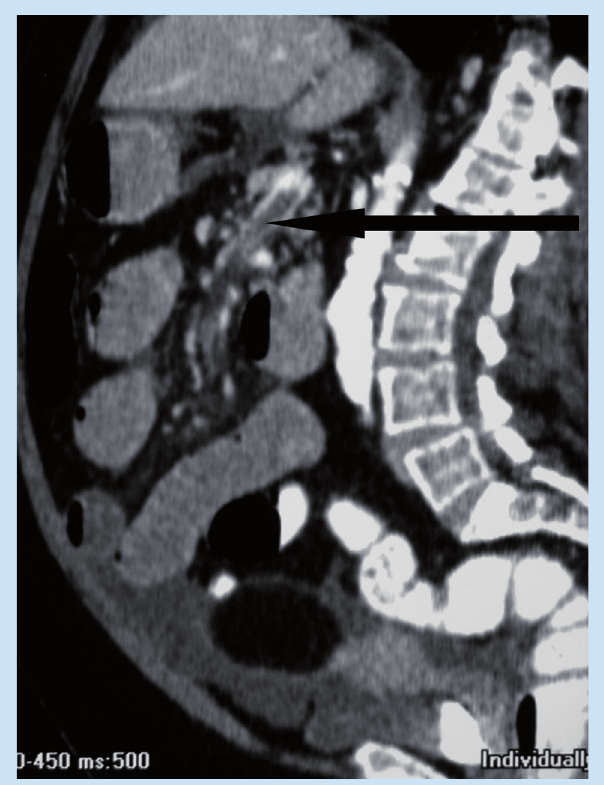
Fig. 1. The porto-venous phase of a contrast-enhanced reconstructed sagittal CT study. The SMV thrombosis is labelled with an arrow and is seen as an area of decreased enhancement in the